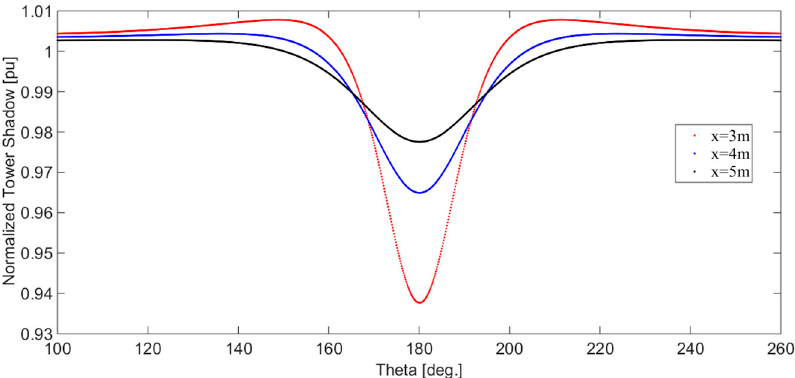
Figure 8. Effect of distance from tower midline 𝑥 on tower shadow. Figure 8. E ff ect of distance from tower midline x on tower shadow.